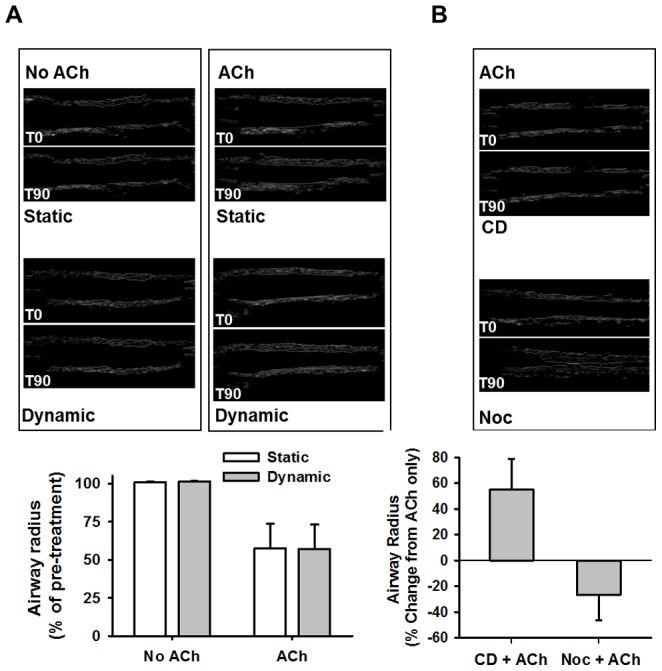
In intact airways, Ach and cytoskeleton, but not dynamic Ptm determine airway diameters.Effects of static or dynamic mechanical loading conditions are shown during acetylcholine-induced (ACh) constriction in intact bovine airways in the absence (A) or presence (B) of cytoskeletal de-depolymerizing agents. Top panels show representative ultrasound images. Bottom graphs show the mean and SD of airway radii relative to pre-treatment condition (A; n: 9 and 10 and B; n: 6 and 8) CD: cytochalasin D, an actin depolymerizing agen; Noc: nocodazole, a microtubule depolymerizing agent.